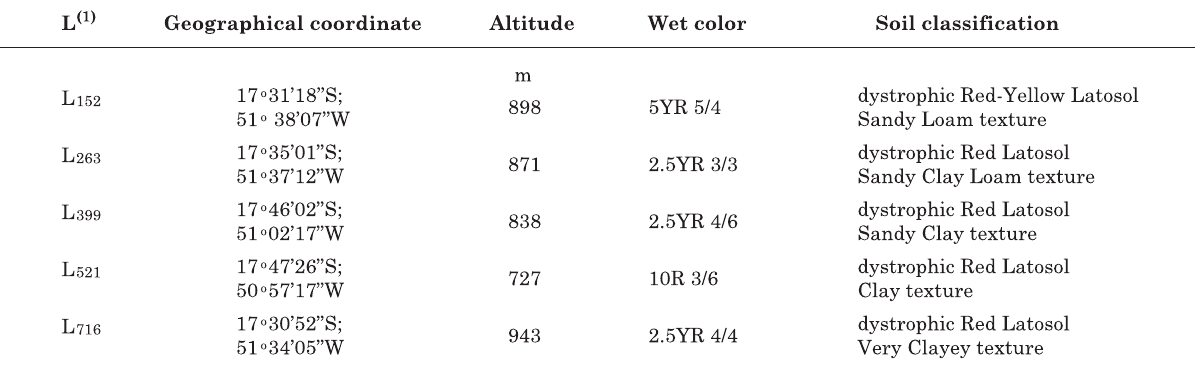
Table 1. Sampling sites and description of Latosols